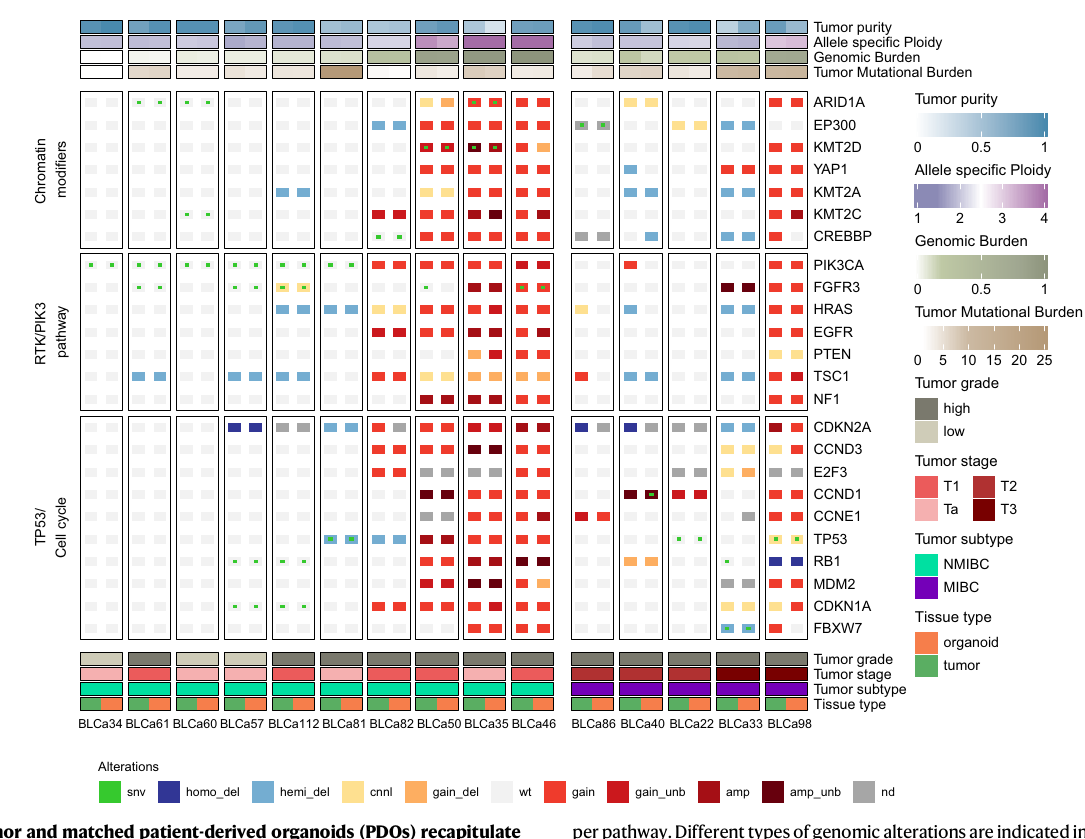
Fig. 4 | Tumor and matched patient-derived organoids (PDOs) recapitulate typical mutational mechanisms of bladder cancer (BLCa). Mutation heat-map. Samples are represented in the columns, with primary tumor on the left (green; n =15biologicalsamples)andPDOsontheright(orange; n =15biologicalsamples). PDO/PT pairs from the same samples are grouped by tumor subtype and ordered by increasing genomic burden within groups. The copy-number pro fi le of the samples with high allele-speci fi c Ploidy (asP, see “ Methods ” ) is characterized by universal copy-number gains and ampli fi cations. Rows represent genes